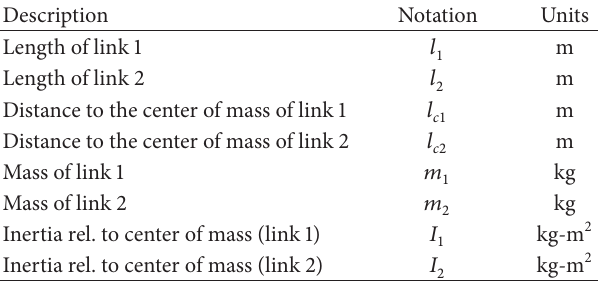
Figure 4: Tracking errors 𝑒 1 (𝑡) and 𝑒 2 (𝑡) by using the PD + Δ sign ( r ) scheme which does not consider any adaptation. see [32, 33]. The links of the arm are made of aluminum and Table 1: Physical parameters of the experimental robot both have a length of 0.15 [m].